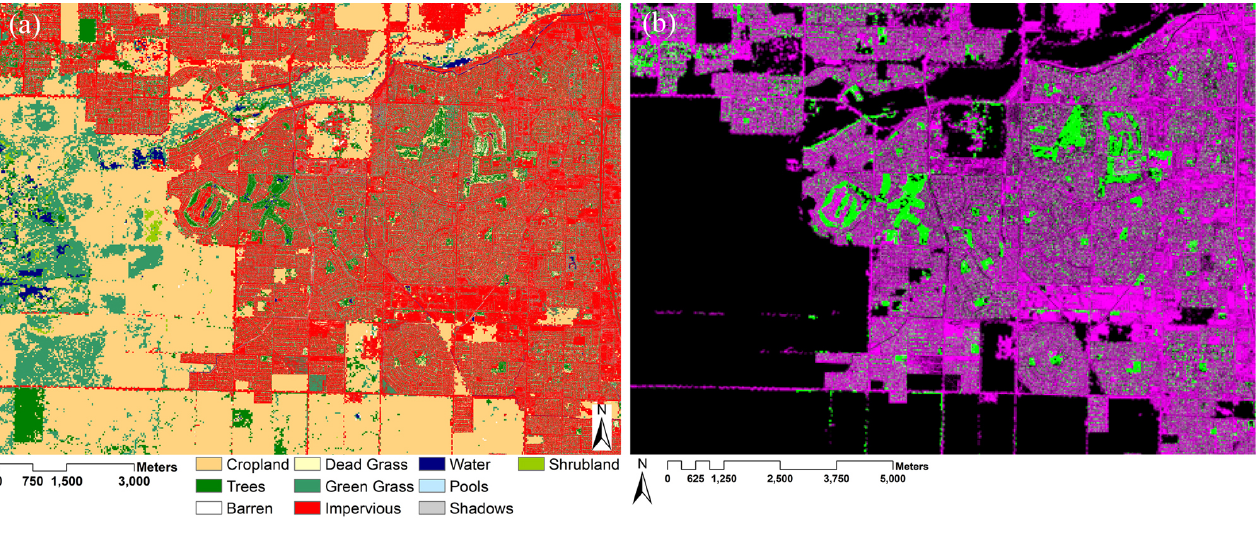
Fig. 3 . (a) Land cover classification and (b) the percentage of trees (green) and the percentage of impervious surface (purple) for the Bakersfield study area. High percentages of trees are distributed across residential portions of the study area in parks and golf courses.